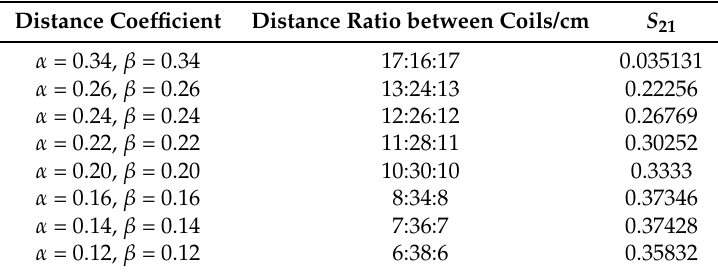
Table 3. The S 21 parameters of the MCR-WPT system with intermediate coil-1, when the transfer distance D = 0.5 m.